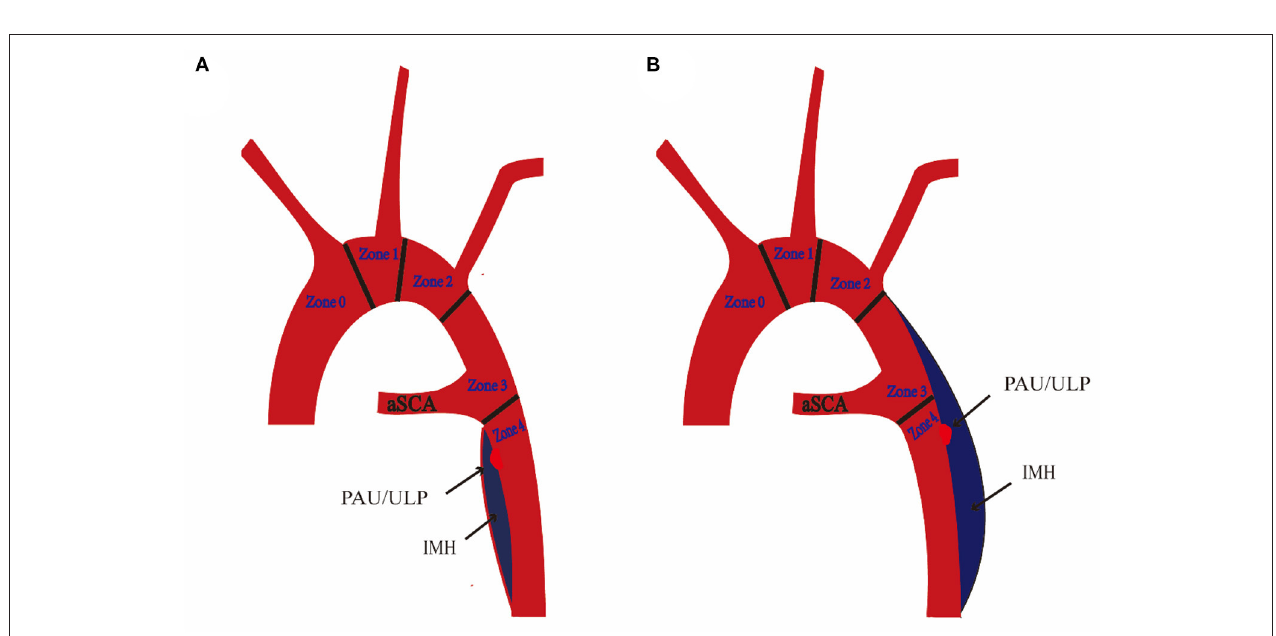
FIGURE 3 | Schematic diagram of aberrant subclavian artery (aSCA) and type B intramural hematoma (TBIMH). (A) Proximal hematoma extending distal to the ostium of aSCA. (B) Proximal hematoma extending distal to the ostium of the left subclavian artery (left-sided aortic arch) or right subclavian artery (right-sided aortic arch). IMH, aortic intramural hematoma; PAU, penetrating atherosclerotic ulcer; ULP, ulcer-like projection.